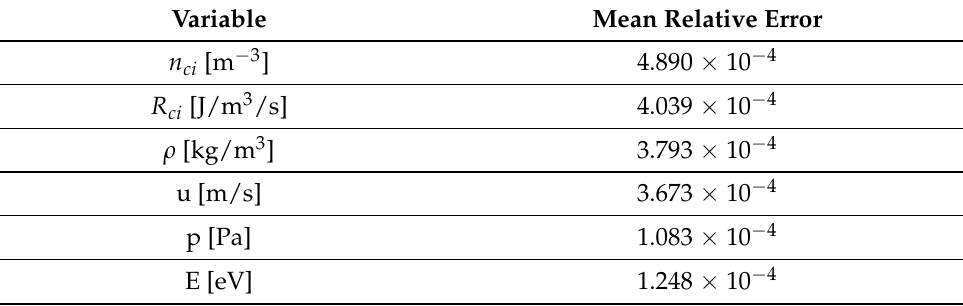
Table 5. Mean relative error associated to inferred